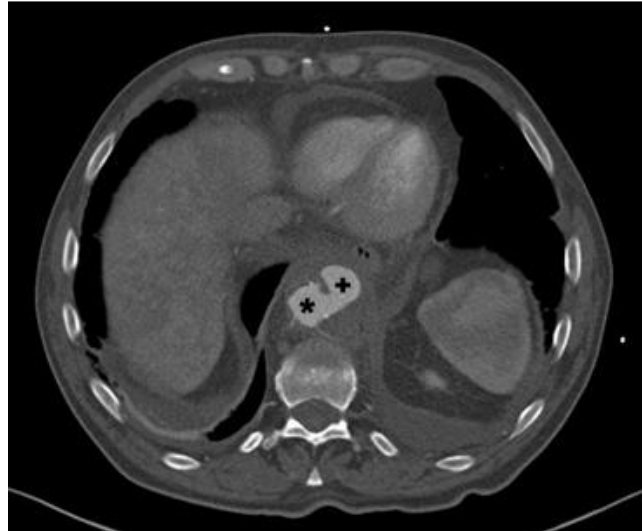
Image 2. Coronal computed tomogram of pseudoaneurysm (+) in descending thoracic aorta